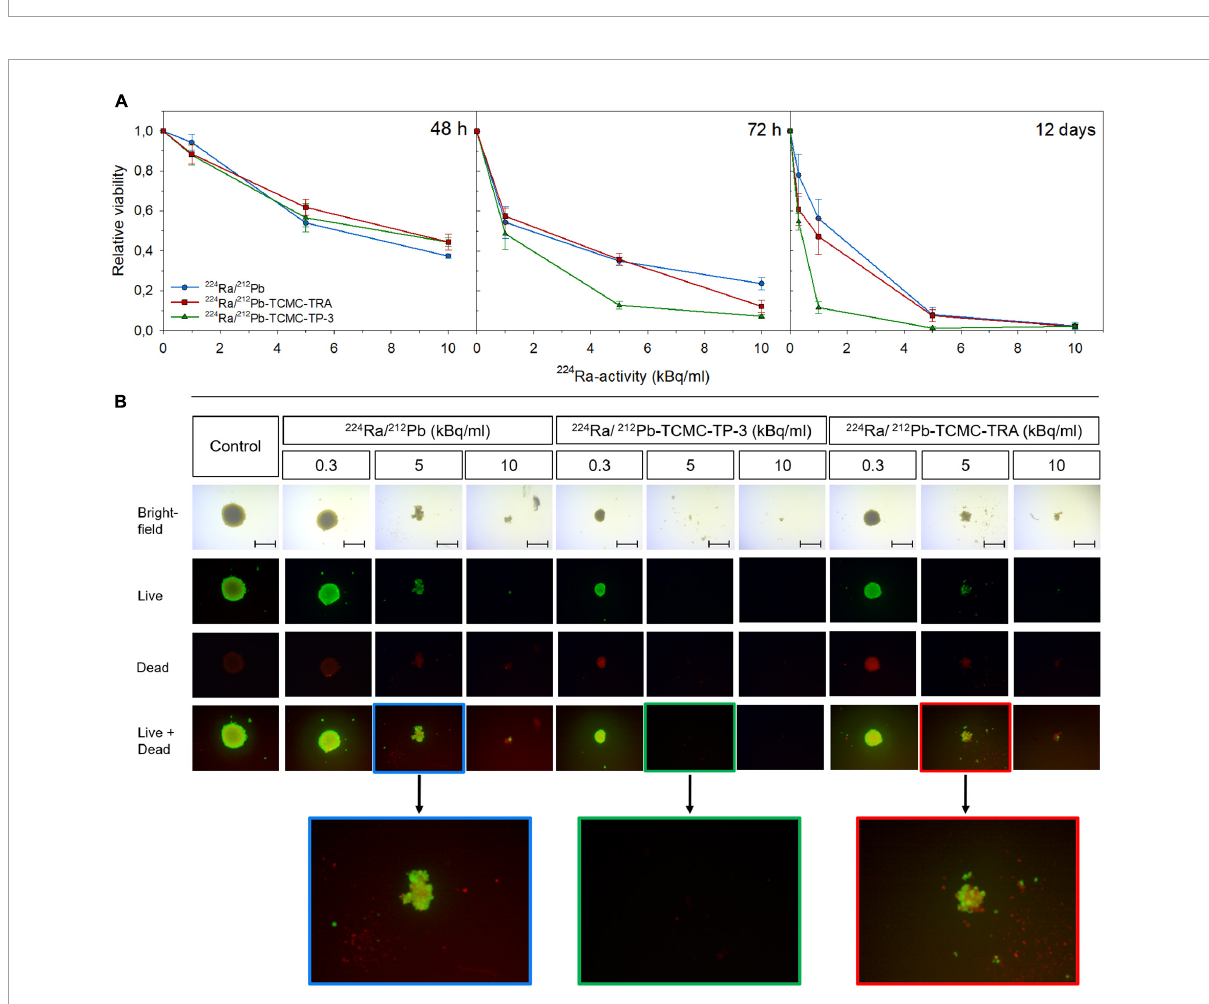
FIGURE4 Viability of OHS spheroids treated with dual alpha solutions. (A) Viability of spheroids 48 h, 72 h, and 12 days after 24 h incubation with 1–10 kBq/ml of 224 Ra/ 212 Pb, 224 Ra/ 212 Pb-TCMC-TP-3 (specific activity of 2.3 MBq/mg) or 224 Ra/ 212 Pb-TCMC-trastuzumab (TRA, specific activity of 3.7 MBq/mg). The relative viability was calculated by dividing the viability of the treated spheroids by the viability of untreated spheroids (0 kBq/ml) at each activity concentration. (B) At day 12, spheroids were stained with fluorescein diacetate and propidium iodide to observe live and dead cells, respectively, before spheroids were imaged (4 × magnification) using an inverted Axiovert 200M microscope (Carl Zeiss AG, Jena, Germany), scale bar = 500 µ m. All spheroids were analyzed with the AxioVision Rel. 4.8 software (Carl Zeiss AG). Spheroids were 60 ± 5.0 × 10 6 µ m 3 at day